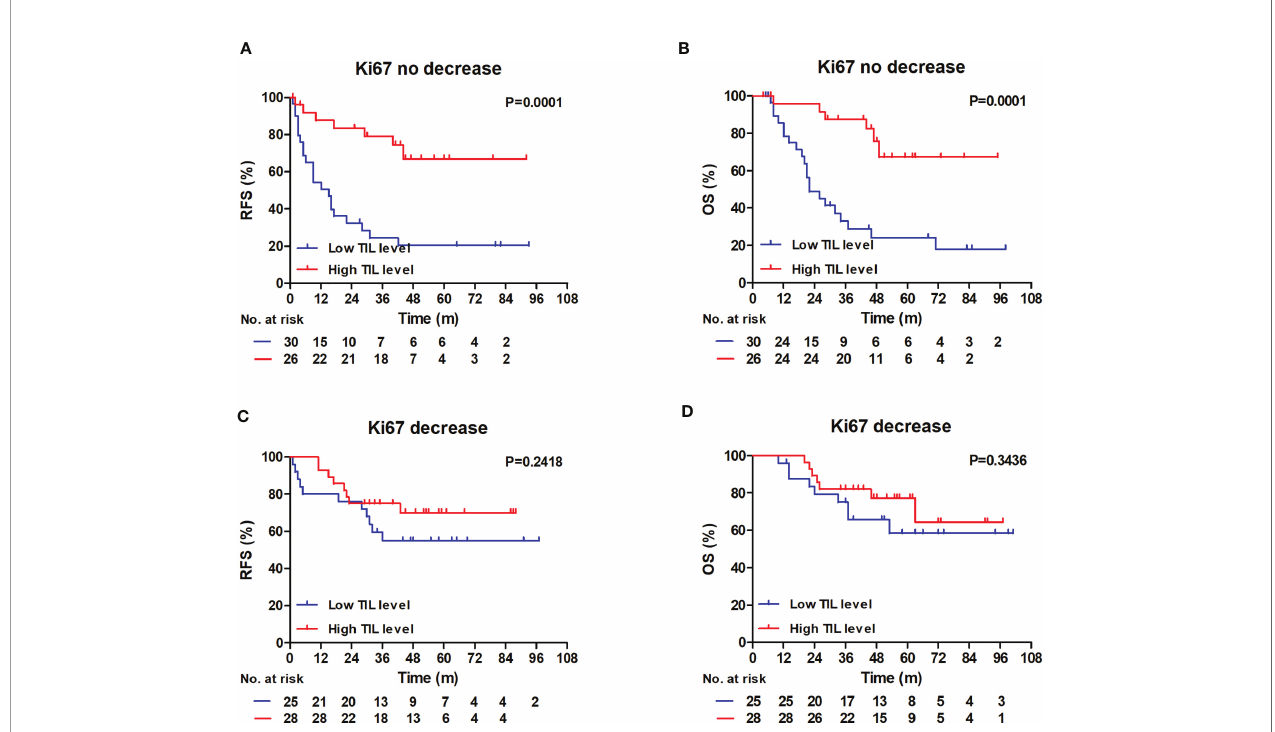
FIGURE 4 | RFS and OS outcomes in the Ki67 no decrease and decrease groups according to the TIL level. (A, B) In Ki67 no decrease group, Patients with low RD TIL levels exhibited reduced 3-year RFS and 3-year OS compared with patients with high RD TIL levels (RFS: 24.4% vs 79.1%, log-rank, P = 0.0001; OS: 33.1% vs 87.5%, log-rank, P = 0.0001). (C, D) In Ki67 decrease group, no signi fi cant differences were showed in RFS and OS graphs (RFS: log-rank, P = 0.2418; OS: log- rank, P = 0.3436). RFS, recurrence-free survival; OS, overall survival; TIL, tumor-in fi ltrating